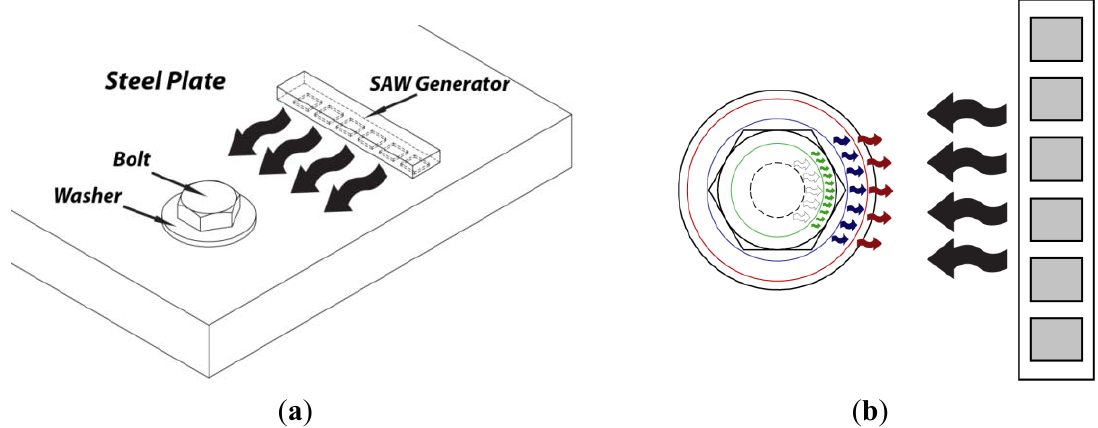
Figure 2. ( a ) Schematic representation of the proposed methodology used to quantify bolt tension; ( b ) representation of surface acoustic wave propagation and reflection from four different boundaries. White arrows represent no load, green arrows low load, blue arrows medium load and red arrows high load. The black arrows represent the incoming acoustic